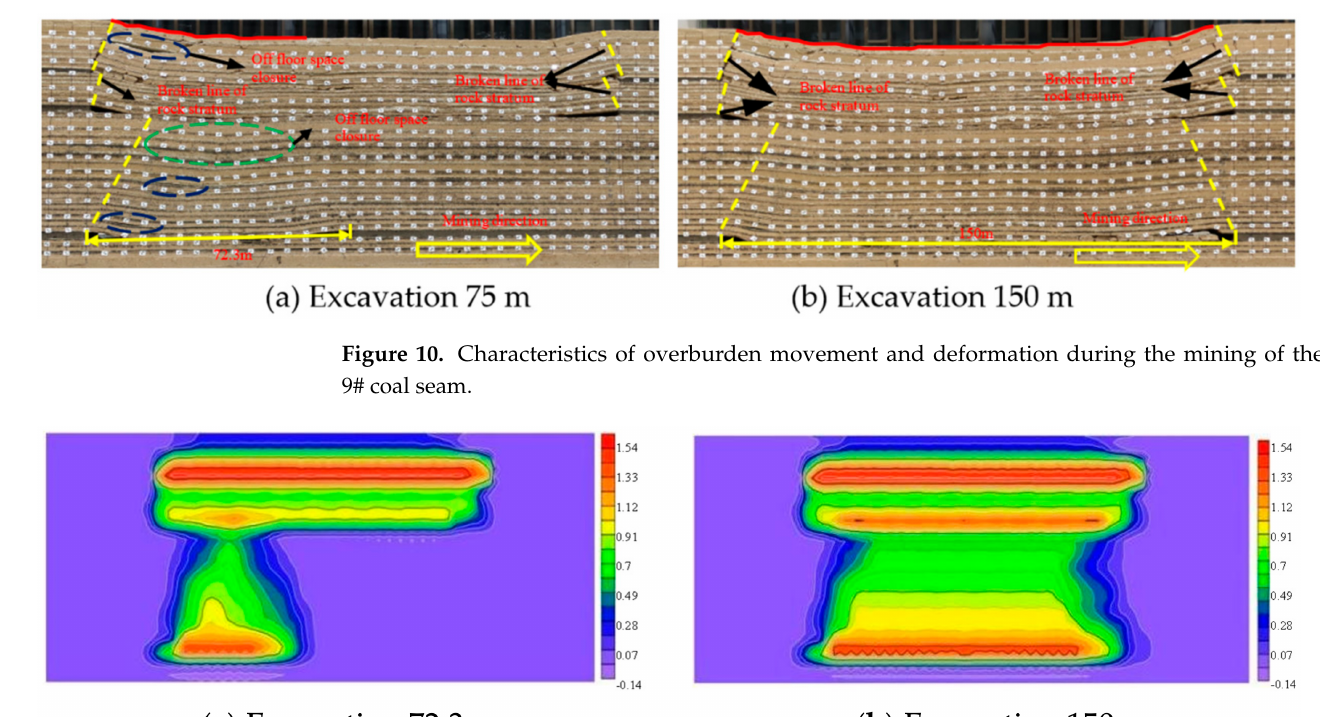
Figure 9. Evolution characteristics of the displacement field of the strata during the mining of the 4# coal seam.